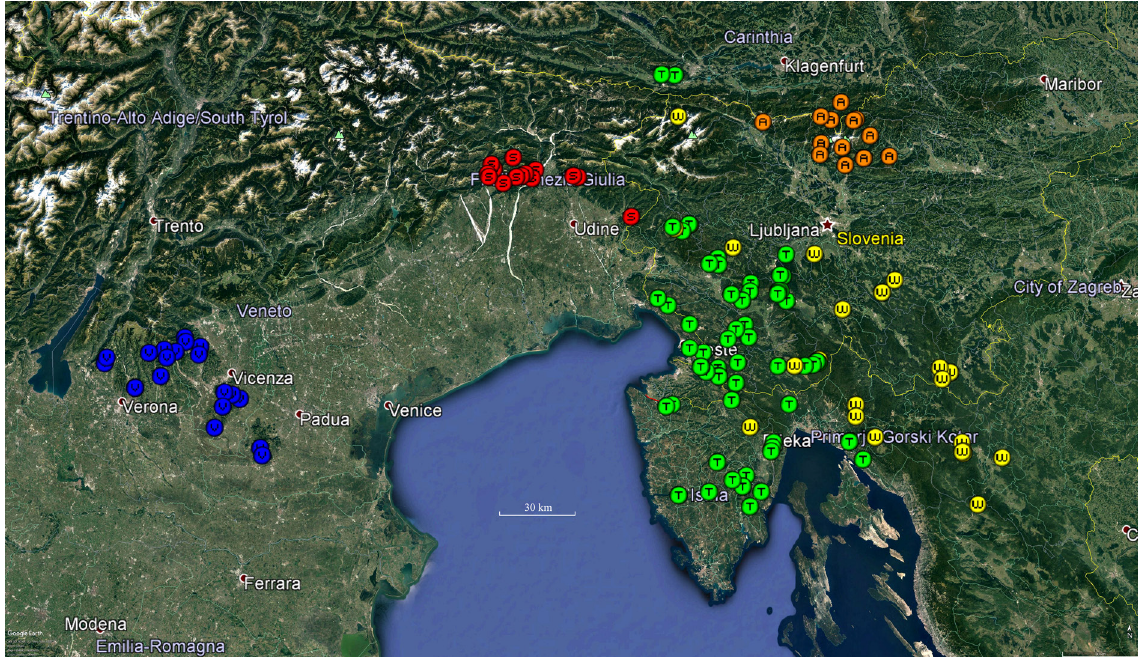
Fig. 1. Map of the sampling localities. Blue dots = Cochlostoma ( Clessiniella ) villae (Strobel, 1851); red dots = Co. ( Cl. ) stelucarum sp. nov.; green dots = Co. ( Cl. ) tergestinum (Westerlund, 1878); yellow dots = Co. ( Cl. ) waldemari (A.J. Wagner, 1897); orange dots = Co. ( Cl. ) anomphale Boeckel,